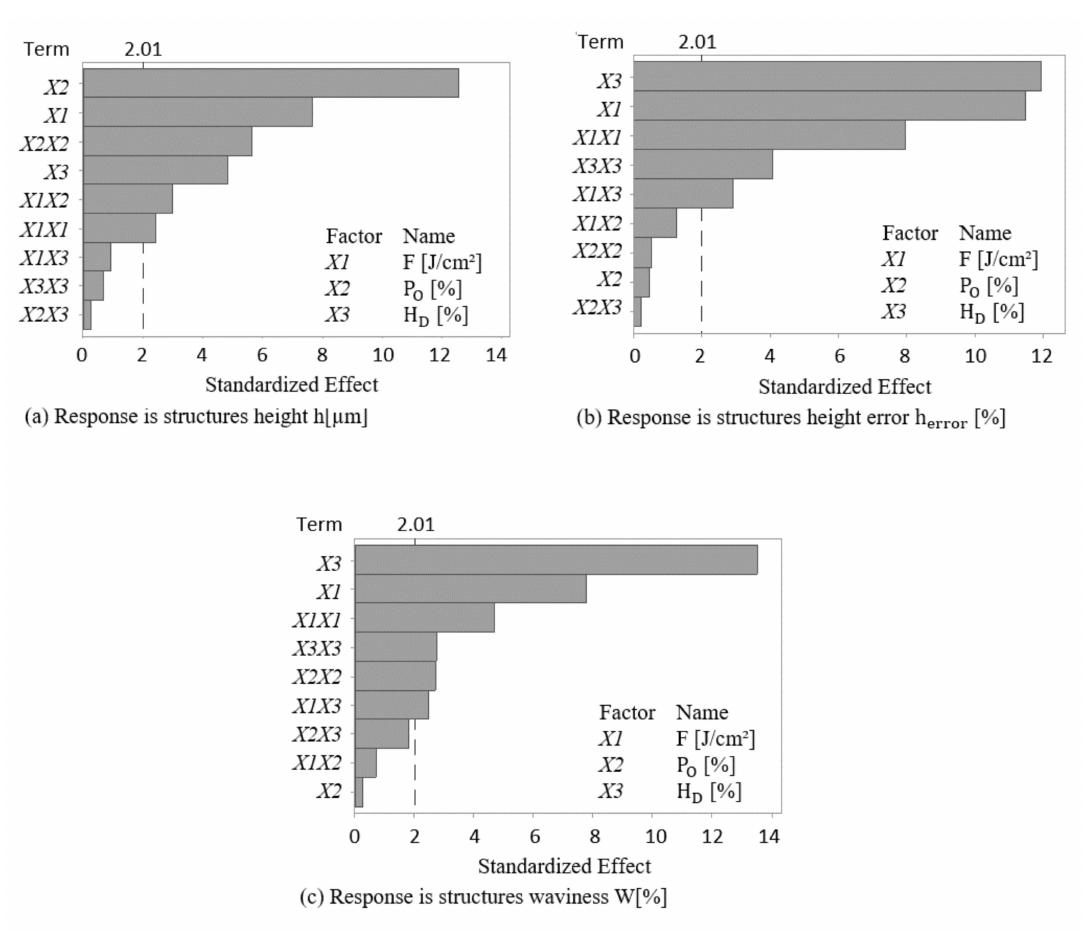
Figure 5. Pareto charts of the standardized e ff ect of ( a ) structures height, ( b ) structures height error, and ( c ) surface